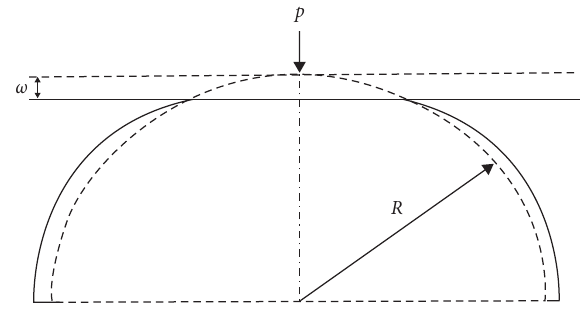
Figure 1: Contact deformation diagram of a single asperity with a rigid